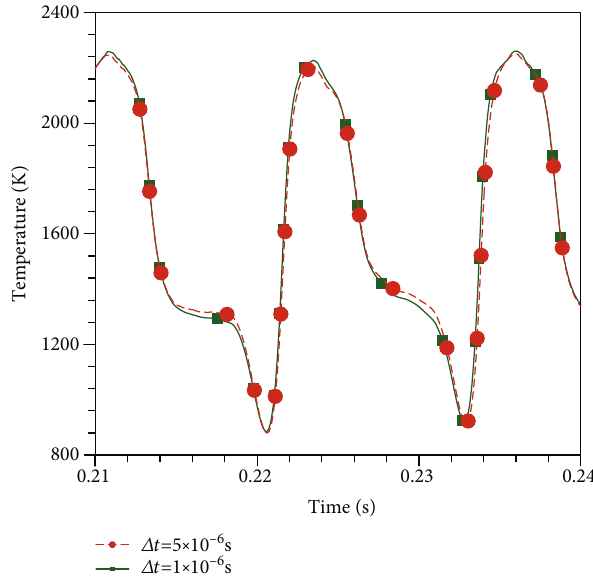
Figure 13: Time histories of the temperature oscillations at P4 with di ff erent time steps for the initial LOX particle diameter of 60 μ